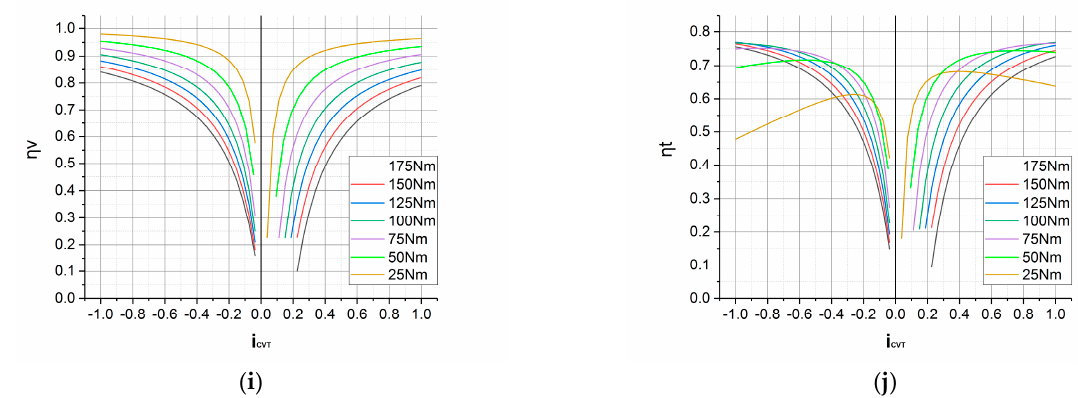
Figure 3. Analysis results of hydrostatic CVT: ( a ) T M = 175 N · m; ( b ) T M = 150 N · m; ( c ) T M = 125 N · m; ( d ) T M = 100 N · m; ( e ) T M = 75 N · m; ( f ) T M = 50 N · m; ( g ) T M = 25 N · m; ( h ) Mechanical efficiency η m ; ( i ) Volumetric efficiency η v ; ( j ) Total efficiency η t